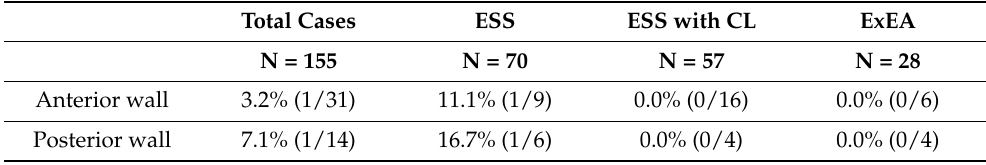
Table 3. Recurrence rates according to the origin site in the maxillary